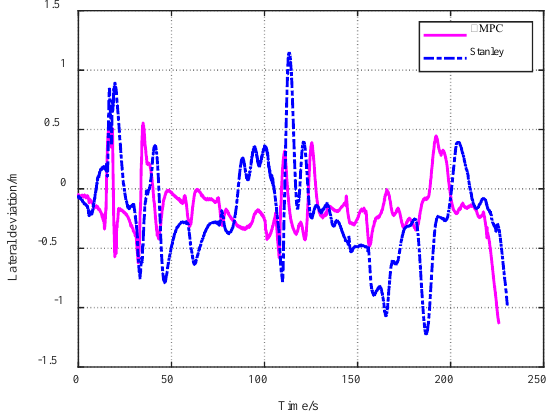
Figure 9. Lateral deviation of MPC control and Stanley control.